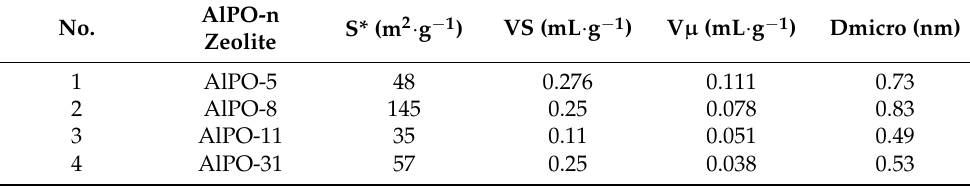
Table 2. The pore properties of the AlPO-5, AlPO-8, AlPO-11 and AlPO-31 zeolites.